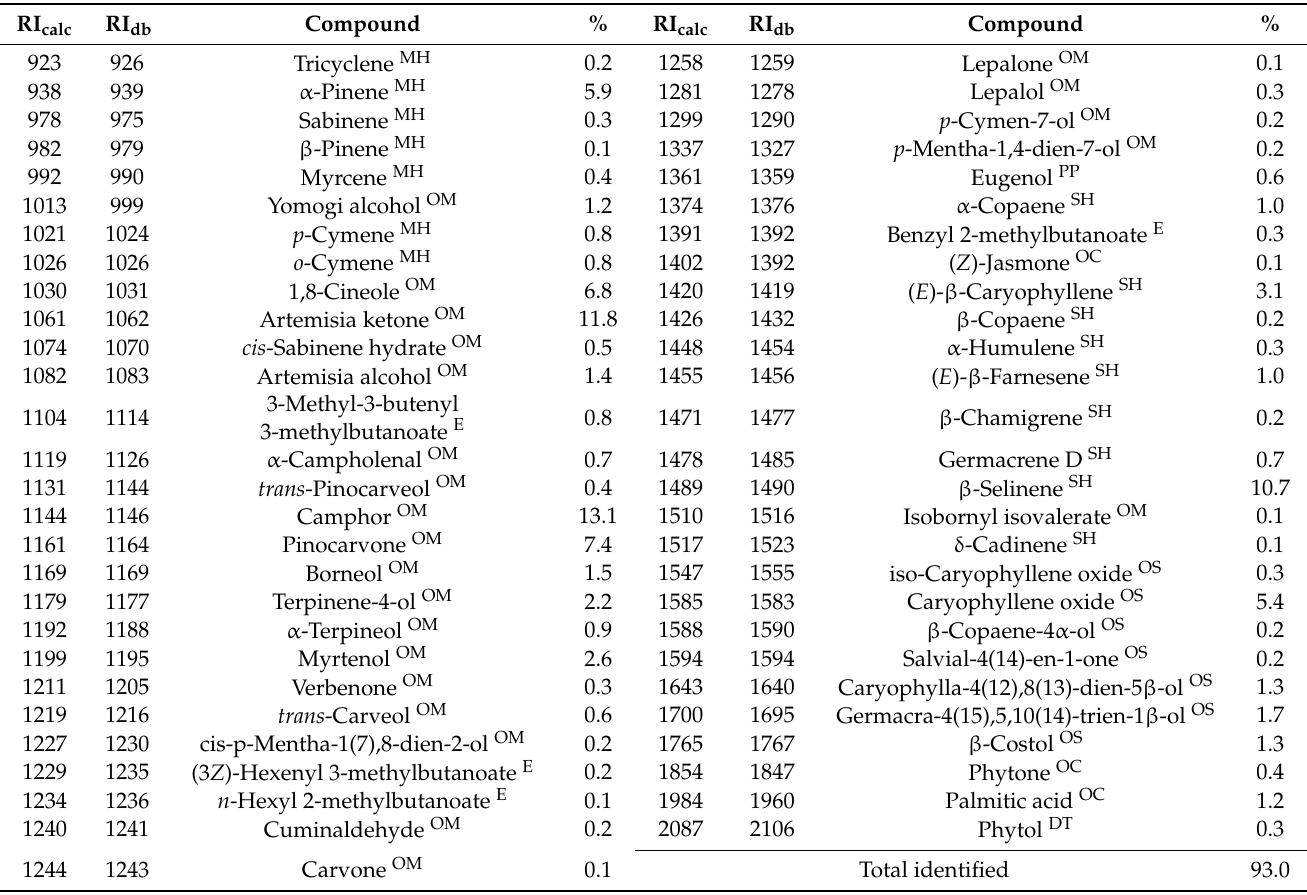
Table 1. Chemical composition of the of Artemisia annua floral essential